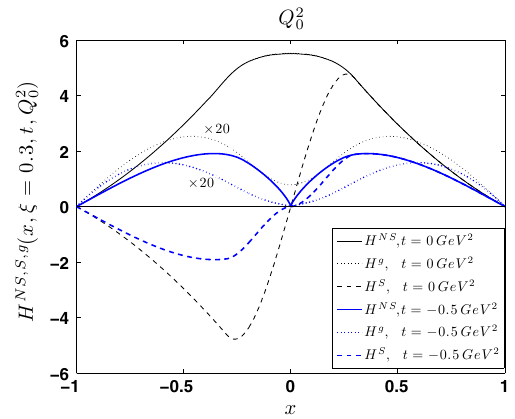
Fig. 11 Comparison of the SW predictions for H NS , S , g at ξ = 0 . 3 and t = 0GeV 2 , thin lines , results as in Fig. 10, and t = 0 . 5GeV 2 , thick lines . The gluon distributions are amplified by a factor of